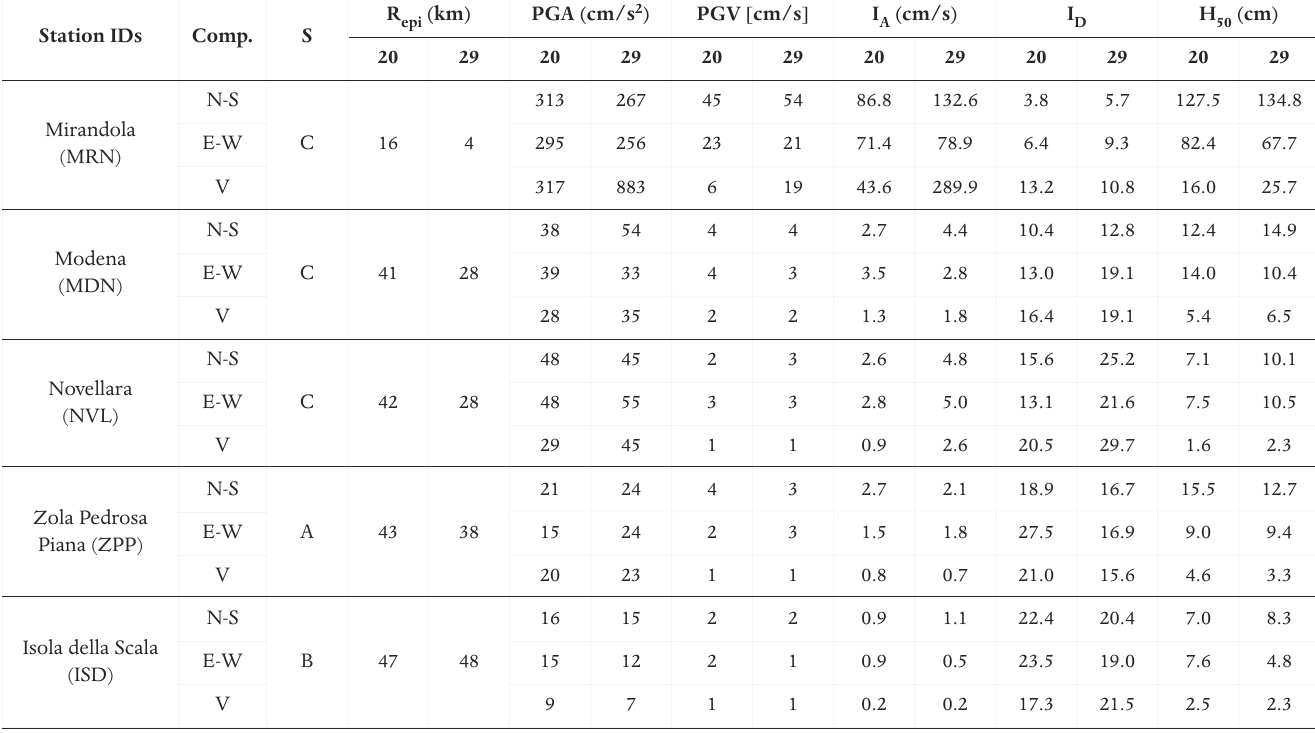
Table 1. Peak and integral intensity measures of the five stations within an epicentral distance <50 km. E-W, east-west; N-S, north-south (referring to hor- izontal components); V, vertical component; 20, 29, May 20 and 29, 2012; S, local site conditions; R , epicentral distance; PGA, peak ground accelera- epi tion; PGV, peak ground velocity; I , Arias intensity; I , Cosenza and Manfredi Index; H , Housner Intensity. A D 50